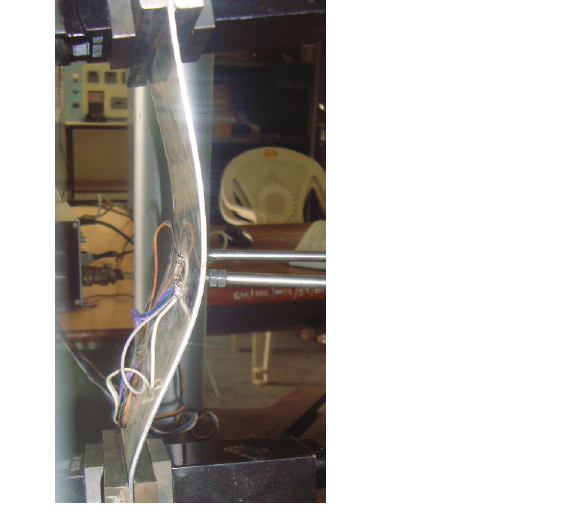
Figure 5 A typical buckled shape of the tested specimen ( α = 15 ° , a/b =